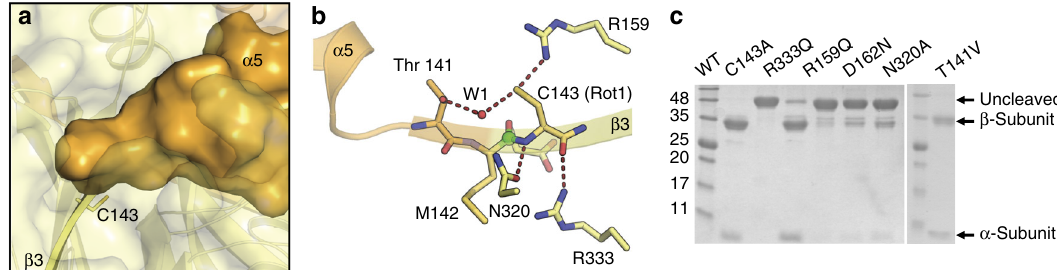
Fig. 2 The inactive state of aCDase. a The presence of an intact junction (residues 140 – 142 shown in surface representation) preceding the active site nucleophile sequesters Cys 143 (modeled; yellow sticks) from solvent. b Active site of the proenzyme form of nmr-aCDase. The modeled rotamer (Rot1) of the active site Cys 143 is shown as yellow sticks. The carbonyl carbon attacked by the Cys 143 thiol side chain is shown as a green sphere. Dashed red lines indicate hydrogen bonds. An active site water (W1) is shown as a red sphere. c Reducing SDS-PAGE of the puri fi ed active site mutants of aCDase following the autocleavage